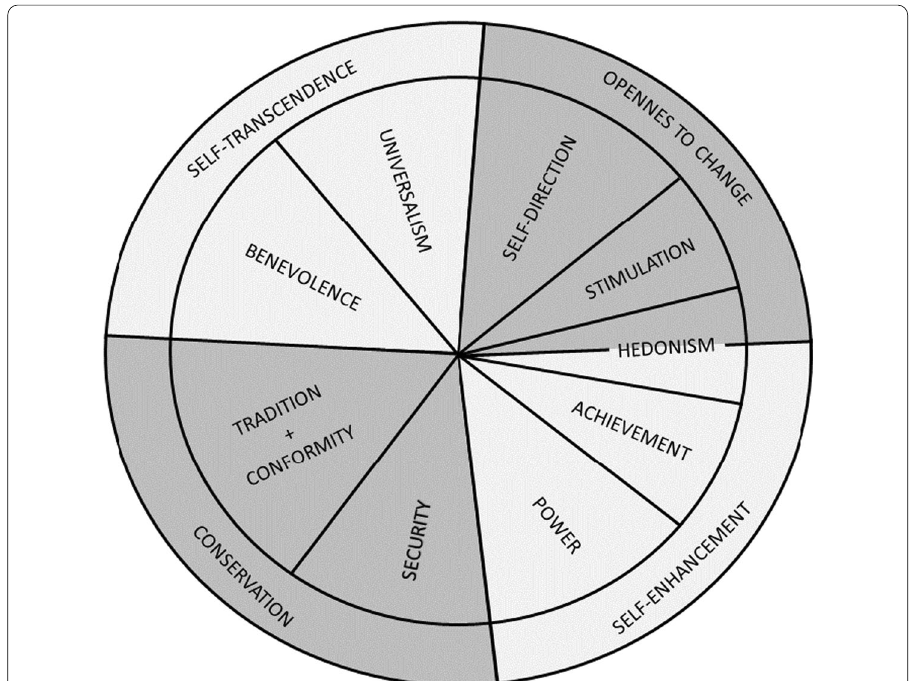
Fig. 1 The Schwartz theory of basic human values. Source : Schwartz (1992), cited in Giménez &Tamajón, 2019, Fig.